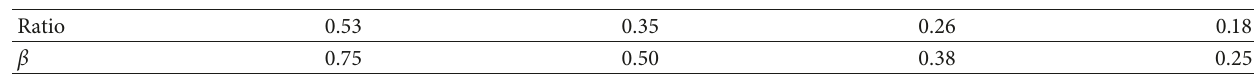
Table 14: Reduction factor β in terms of the ratio between the base shear force under isolated and fixed-base conditions. Chinese code